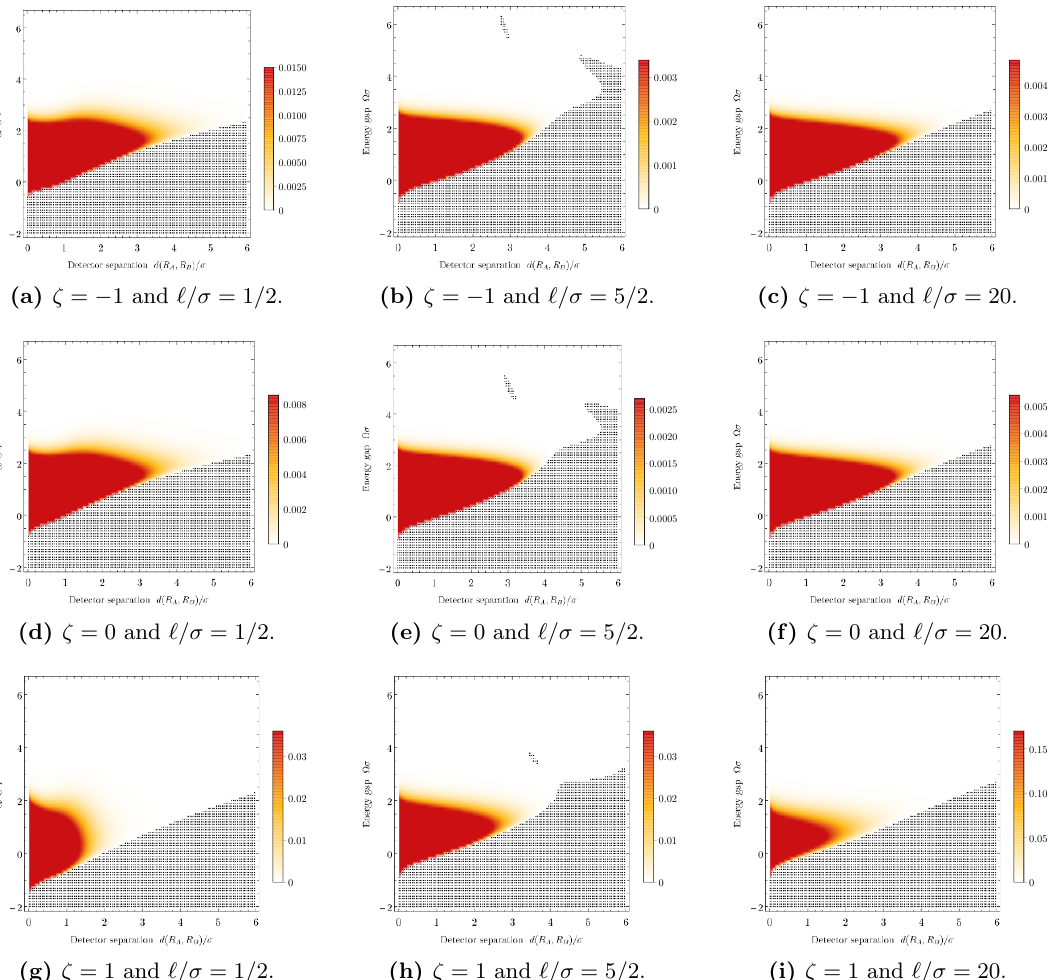
Figure 7 . The concurrence C = ~ (cid:21) 2 associated with the state (cid:26) AB describing two static detectors is plotted as a function of their proper separation d ( R A ; R B ) =(cid:27) and energy gap (cid:10) (cid:27) for all boundary conditions (cid:16) = f(cid:0) 1 ; 0 ; 1 g and di(cid:11)erent values of the AdS length ‘=(cid:27) . Detector A is located at the origin. The area (cid:12)lled with black dots represents the region where the concurrence vanishes and thus no entanglement harvesting is